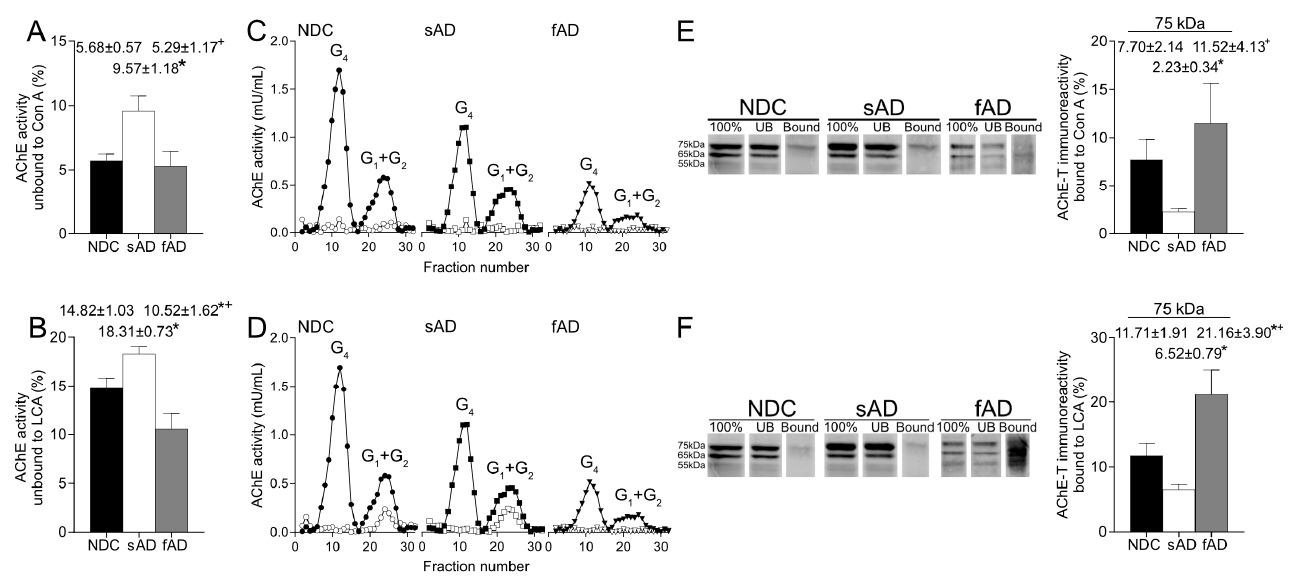
Figure 2. Glycosylation of active and inactive brain AChE species. Lectin-binding analyses of brain cortices extracts from non-demented controls (NDC), sAD, and fAD (n = 4 for each group) were performed by interaction with Concanavalina ensiformis (Con A) and Lens culinaris (LCA) lectins. After incubation of brain extracts with the lectins, the unbound fraction (the fraction not recognized by the lectin) was separated from the bound fraction by centrifugation. AChE enzymatic activity was measured in the fraction not recognized by ( A ) Con A or ( B ) LCA. Results are expressed as percentage over the total. The binding of AChE molecular forms with the lectins ( C ) Con A or ( D ) LCA was analyzed by comparison of the sedimentation profiles of brain extracts prior to interaction (closed symbols) with the profiles of non-recognized unbound fractions (open symbols). Representative profiles of molecular forms of AChE in NDC, sAD, and fAD are shown. Interaction of AChE protein with ( E ) Con A or ( F ) LCA was assayed by Western blotting of the brain extract (100%) and both the recognized (bound) and non-recognized (UB) fractions. Illustrative Western blots of AChE-T species are shown. To the right, densitometric quantification of the percentage of binding of the 75-kDa immunoreactive band to Con A or LCA. The graphs represent mean ± SEM. * indicates statistically different ( p values < 0.05) with respect to NDC and + significantly different from sAD. One-way ANOVA with Tukey’s multiple comparisons was applied for ( A , F ) and Kruskal–Wallis test with Dunn’s multiple comparisons for ( B , E )